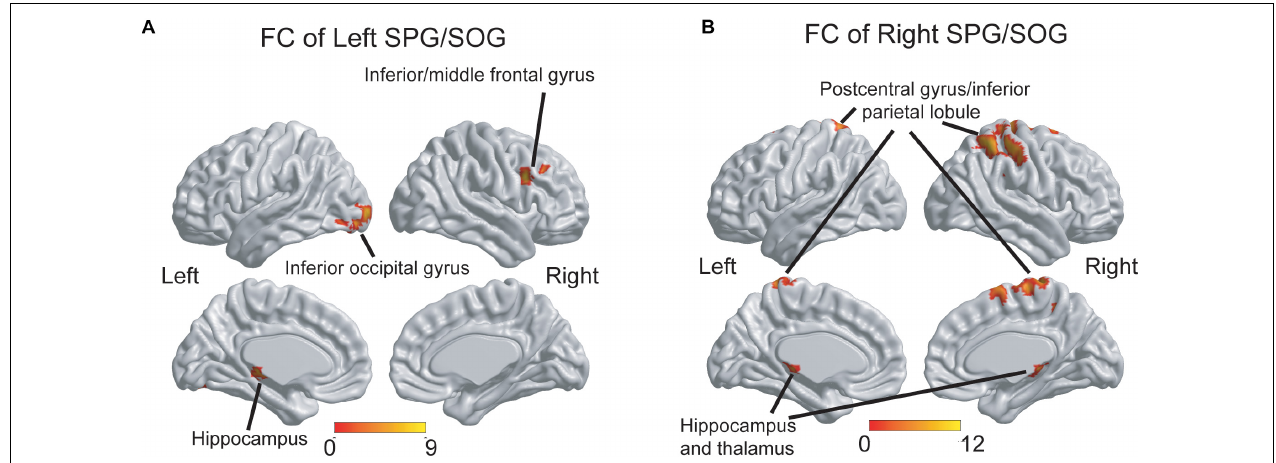
FIGURE 3 | The group differences of FC patterns of the bilateral SPG/SOG. (A) Significant group differences of FC of the left SPG/SOG were shown in frontal, temporal and occipital regions. (B) Significant group differences of FC of the right SPG/SOG were shown in parietal, temporal, and thalamus regions. The thresholds were set at a corrected P < 0.01, determined by Monte Carlo simulation for multiple comparisons (voxel-wise P < 0.01, FWHM = 7.4 mm, cluster size > 2160 mm 3 ). The color bars are presented with F -values. FC, functional connectivity; SPG, superior parietal gyrus; SOG, superior occipital gyrus.